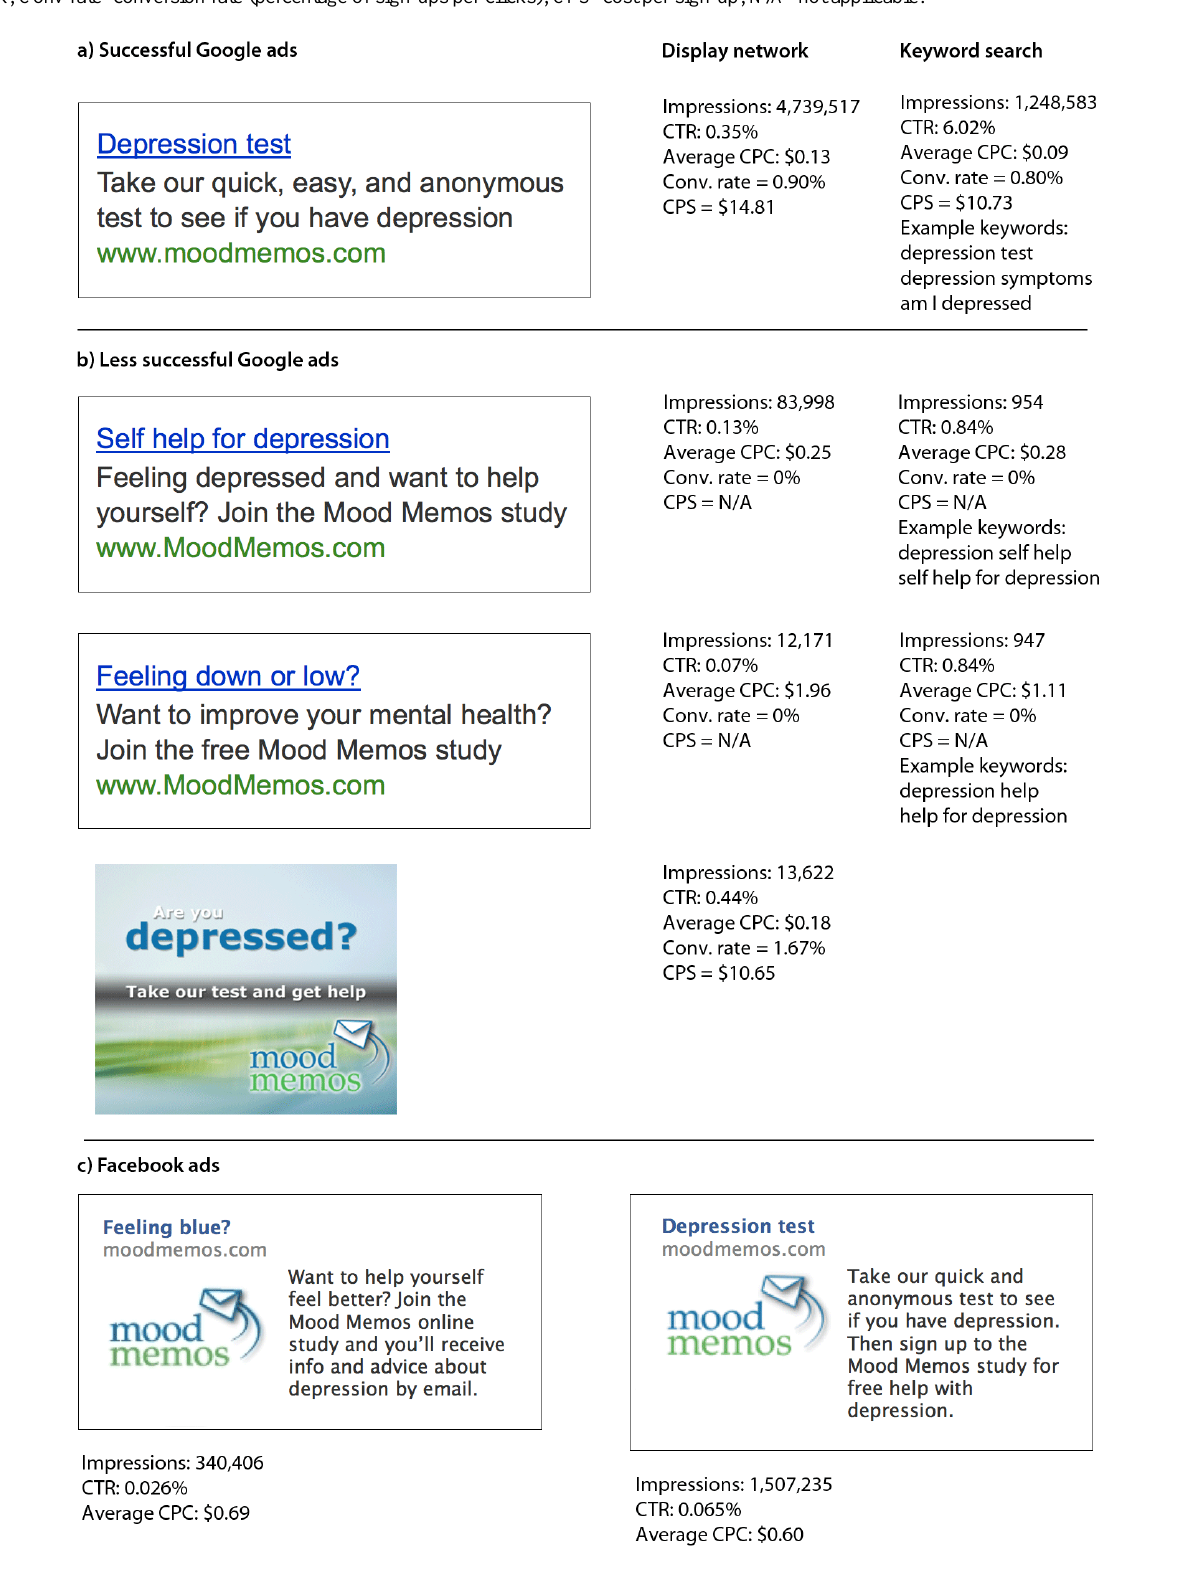
Figure 1. Examples of paid advertisements in the Mood Memos study. CTR=click-through rate (percentage of clicks per impressions); CPC=cost per click; Conv rate=conversion rate (percentage of sign-ups per clicks); CPS=cost per sign-up; N/A=not